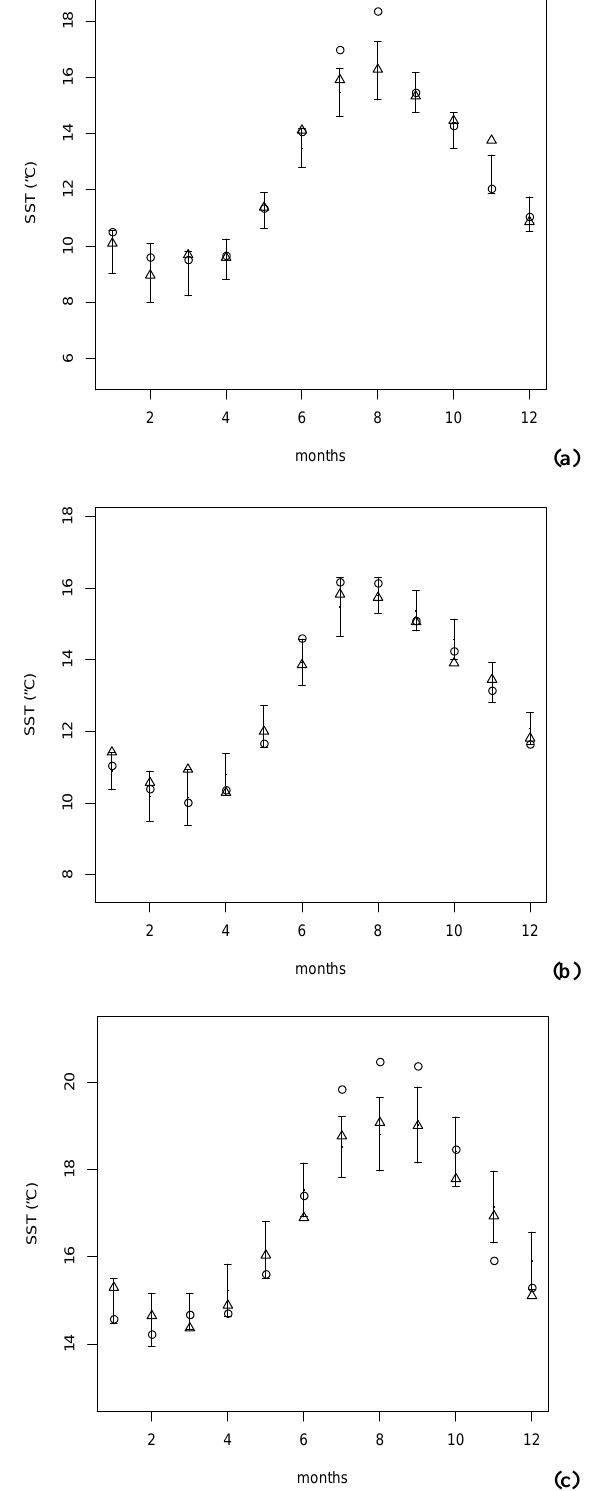
Fig. 8. Error bar plots of sea surface temperature at tide gauge loca- tions for 1975 (triangles) and 1976 (circles). (a) Newlyn, (b) Brest and (c)